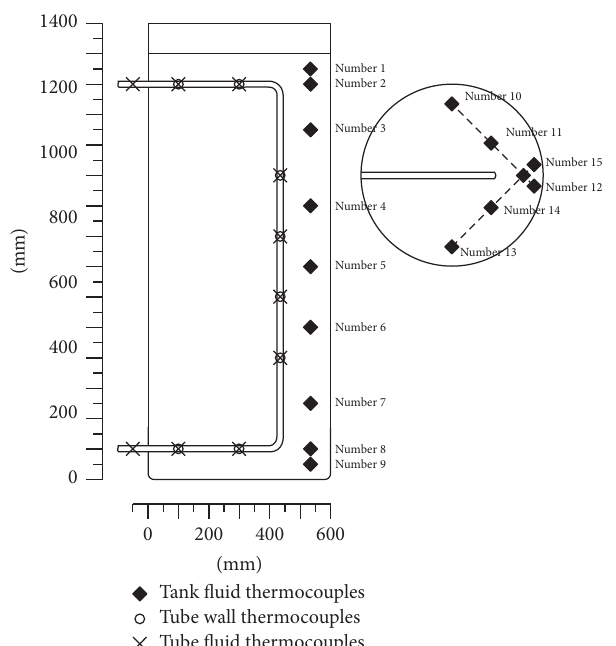
fluid temperatures. Four wall thermocouples were welded on each position of the tube outer surface to get an average wall temperature. Six tank water thermocouples were in 2 equal groups, located at two different positions along vertical direction of the tank. The group number 10 ∼ 12 is higher than the group number 13 ∼ 15. The arithmetic mean of the 3